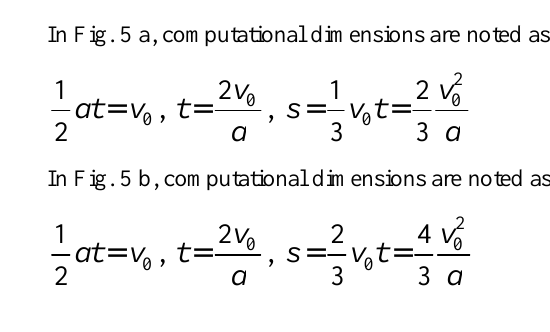
Fig 5. A deceleration rate of triangular form a – sag till zero time; b – level till zero